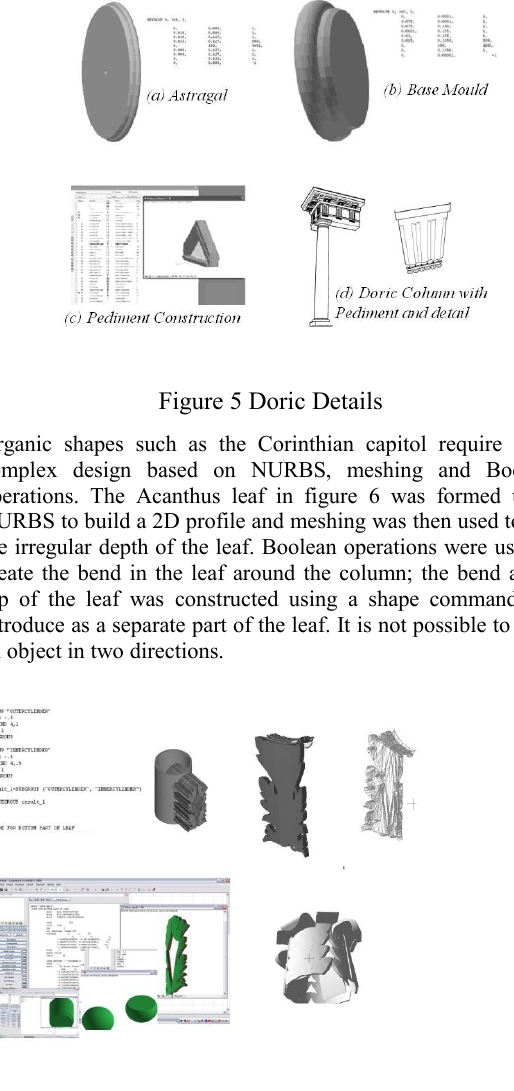
Figure 6 Corinthian Capitol based on NURBS, Meshing and Boolean Operations